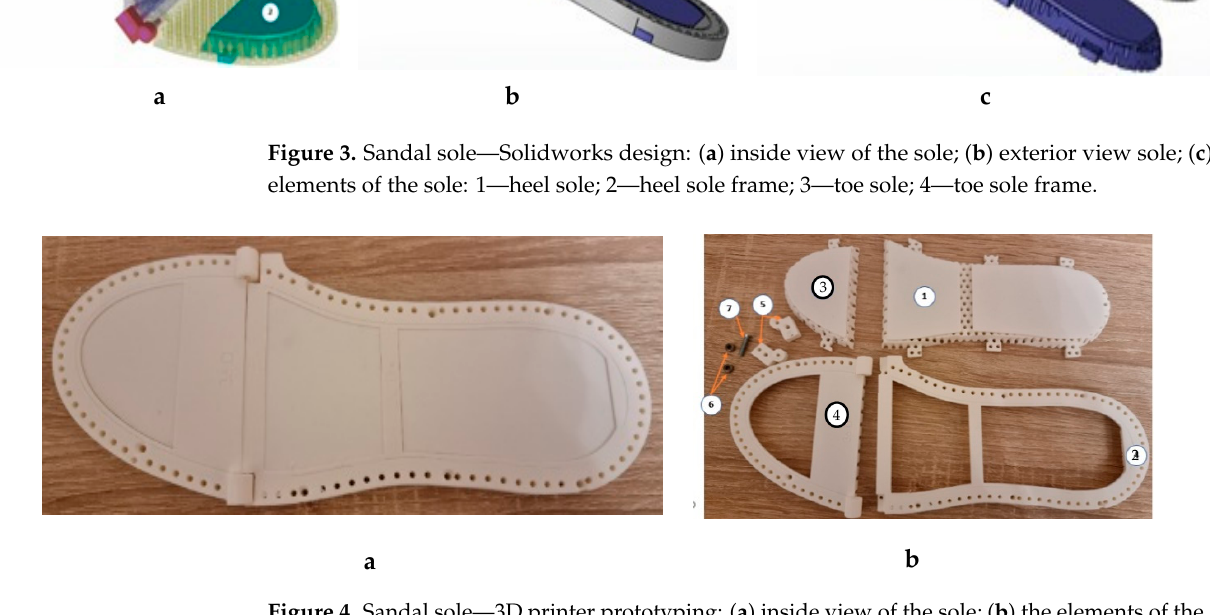
Figure 4. Sandal sole—3D printer prototyping: ( a ) inside view of the sole; ( b ) the elements of the sole: 1—heel sole; 2—heel sole frame; 3—toe sole; 4—toe sole frame; 5, 6 and 7: rotating joint components: 5—bearing support, 6—bearing, 7—screw.